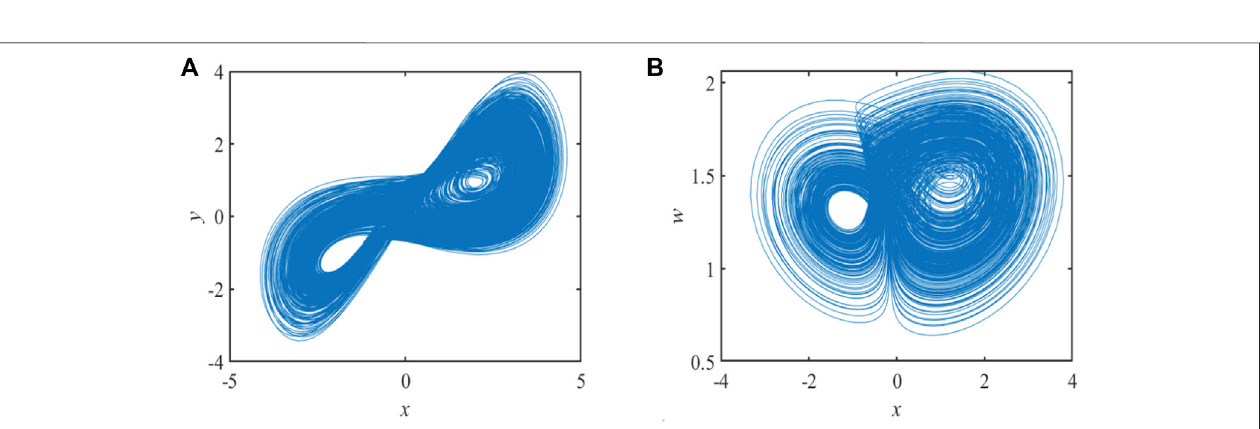
FIGURE 2 | Chaotic attractor of system (3): (A) X - Y plane, (B) X - W plane.